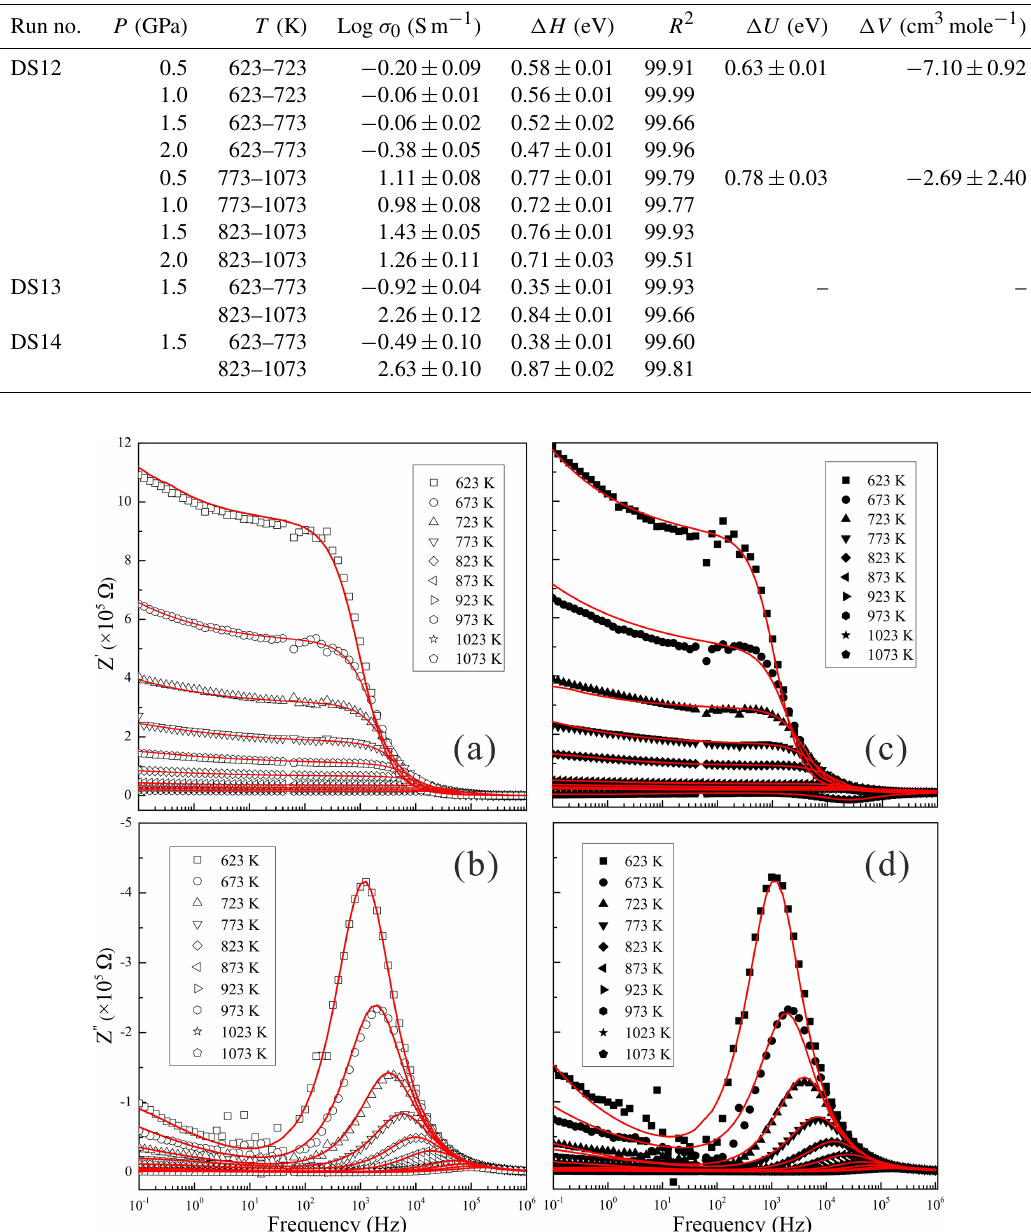
Table 3. Fitted parameters of the Arrhenius relation for the electrical conductivity of three gneiss samples. Two equations, σ = σ 0 exp ( − (cid:49)H/kT ) and (cid:49)H = (cid:49)U + P(cid:49)V , are adopted in which σ 0 is the pre-exponential factor (Sm − 1 ), (cid:49)H is the activation enthalpy (eV), k is the Boltzmann constant (eVK − 1 ), T is the absolute temperature (K), (cid:49)U is the activation energy (eV), P is the pressure (GPa) and (cid:49)V is the activation volume (cm 3 mole − 1 ). The symbol R 2 is denoted as the fitted correlation coefficient. Run no.